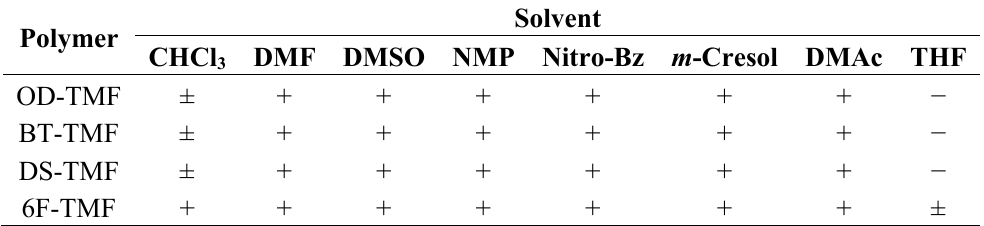
Table 1. Summary of solubility tests carried out with 5 wt% of TMF-based polyimides dissolved in several organic solvents.